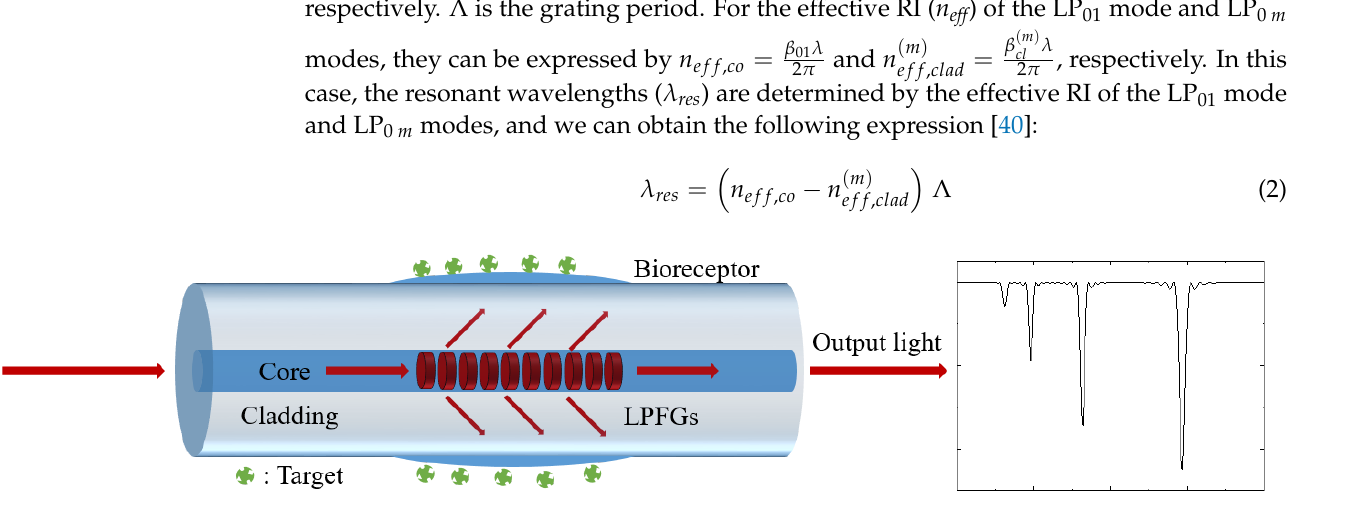
Table 1. Comparison different methods to enhance LPFG-based biosensors.